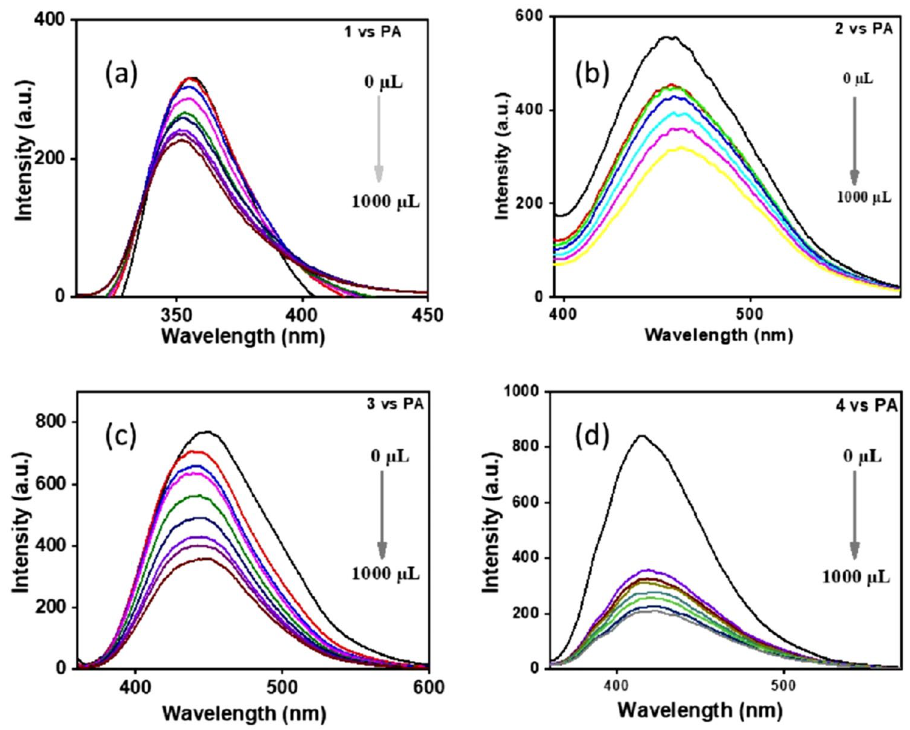
10 −6 M, 31.0 × 10 −6 M and 33.3 × 10 −6 M for all (additions of 0μL, 100μL, 200μL, 300μL, 500μL, 700μL, 900μL, and